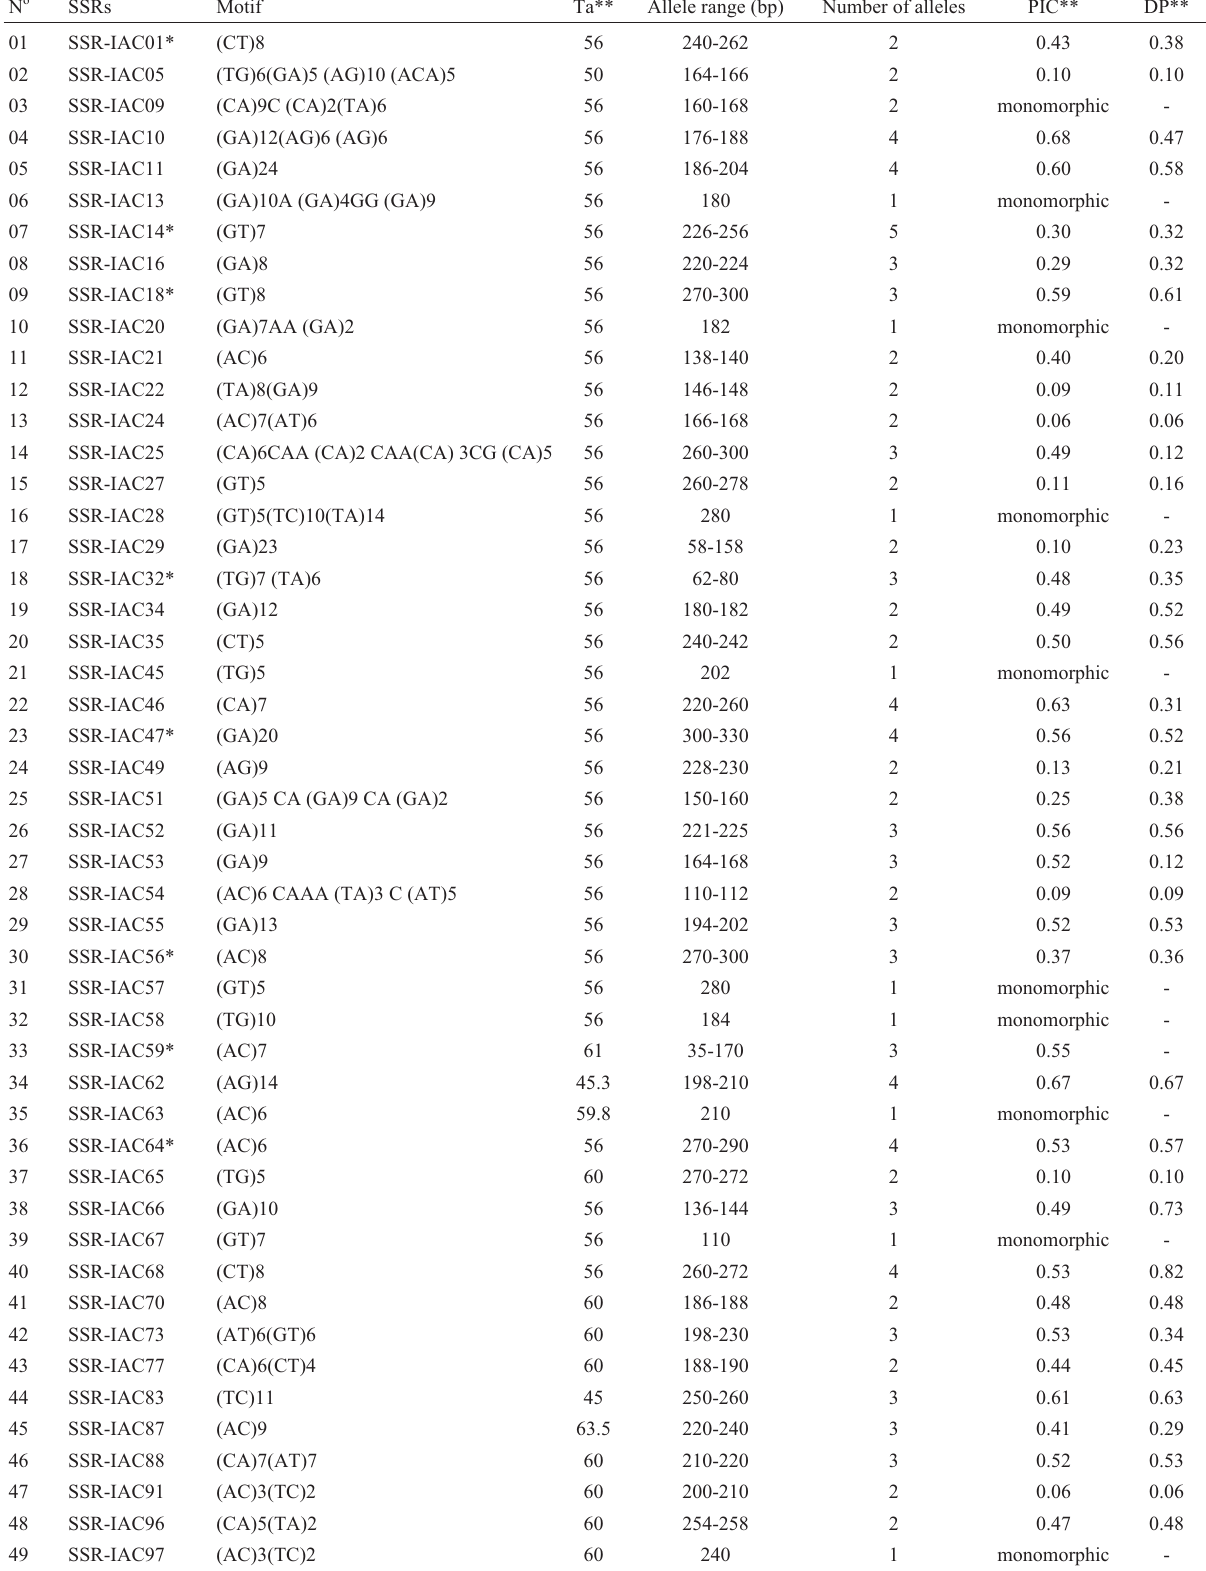
Table 2 - Data from 85 microsatellites used to genotype the 60 carioca accessions (cream-striped grain type). Of the 85 SSRs screened, 20 were geno- typed using a fluorescence technique